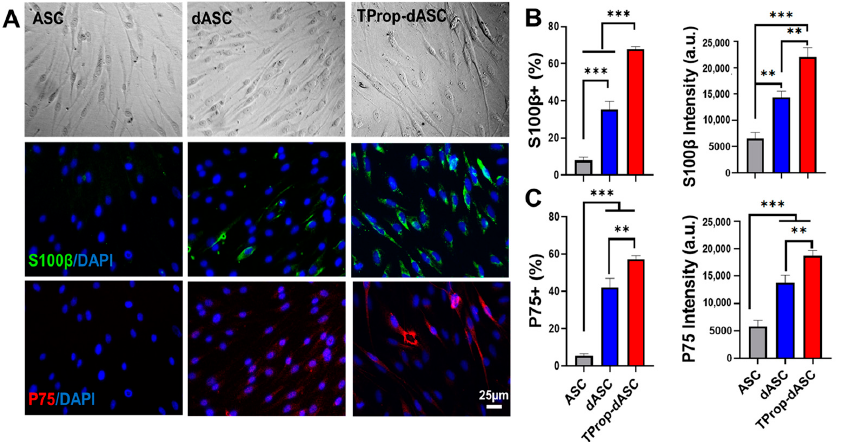
Figure 3. Characterization and comparison of Schwann-cell-like differentiation from ASCs with and without TProp after fourteen days of treatment. ( A ) Bright field images and immunofluorescence staining indicated the different levels of S100 (green) and P75 (red) protein expression in undifferentiated ASCs (ASC), differentiated ASCs (dASC), and differentiated ASCs treated with 50 µ M TProp (TProp-dASC). The scale bar is 25 μ m. Quantitative analysis of positive cell percentage and intensity of S100 ( B ) and P75 ( C ). Data represented mean ± SEM ( n = 3); ** p < 0.01, and *** p < 0.001, one-way ANOVA with Tukey’s post-test.